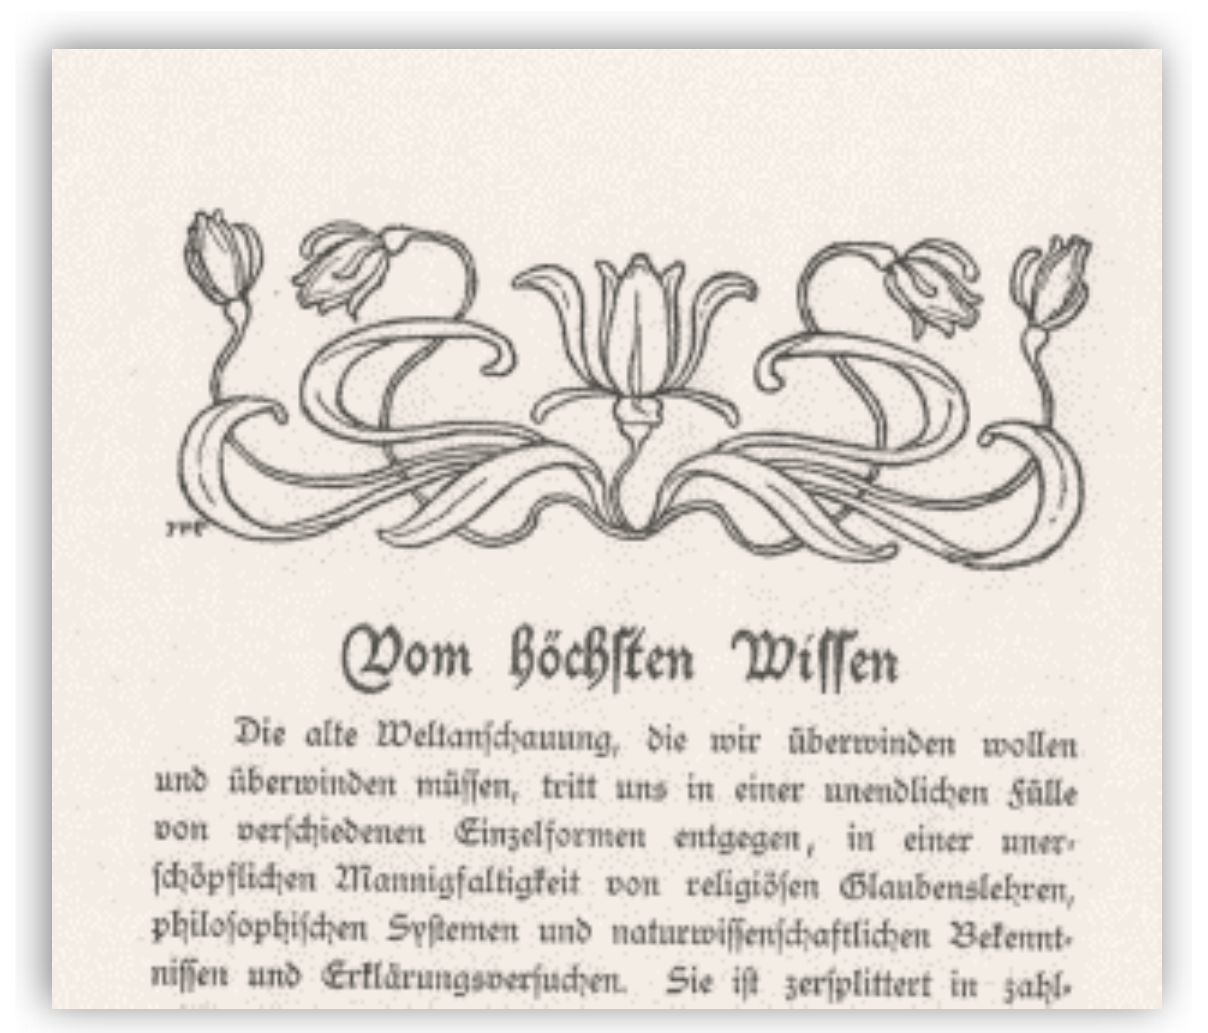
Figure 4. Adorned title page of the essay “Of higher knowledge” ( Vom höchsten Wissen ).